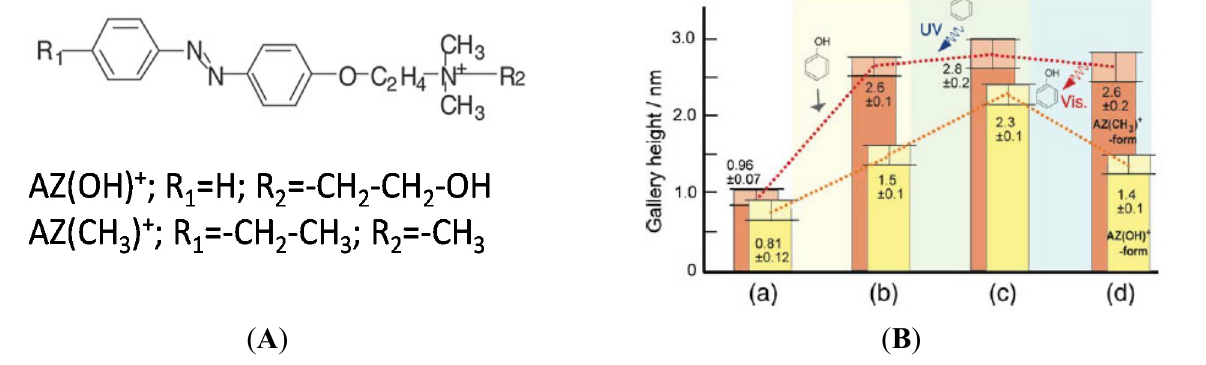
Figure 4. The structure of the AZ-dye used for the clay modification ( A ); The change in the gallery heights of AZ(CH 3 ) + - and AZ(OH) + -montmorillonites ( B ): (a) before the intercalation of phenol, (b) after phenol intercalation, (c) after UV irradiation and (d)